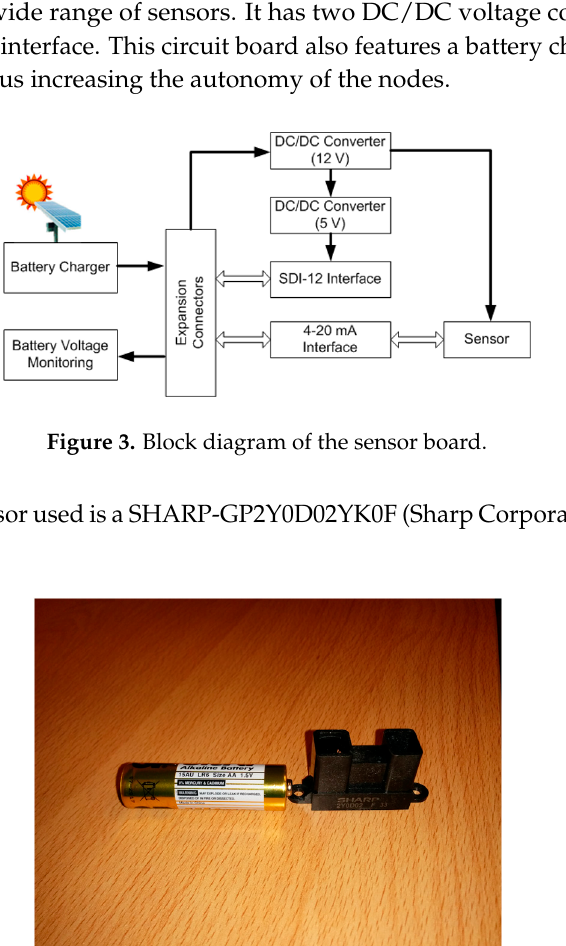
Figure 4. SHARP-GP2Y0D02YK0F sensor alongside a standard AA battery to give an idea of its size.